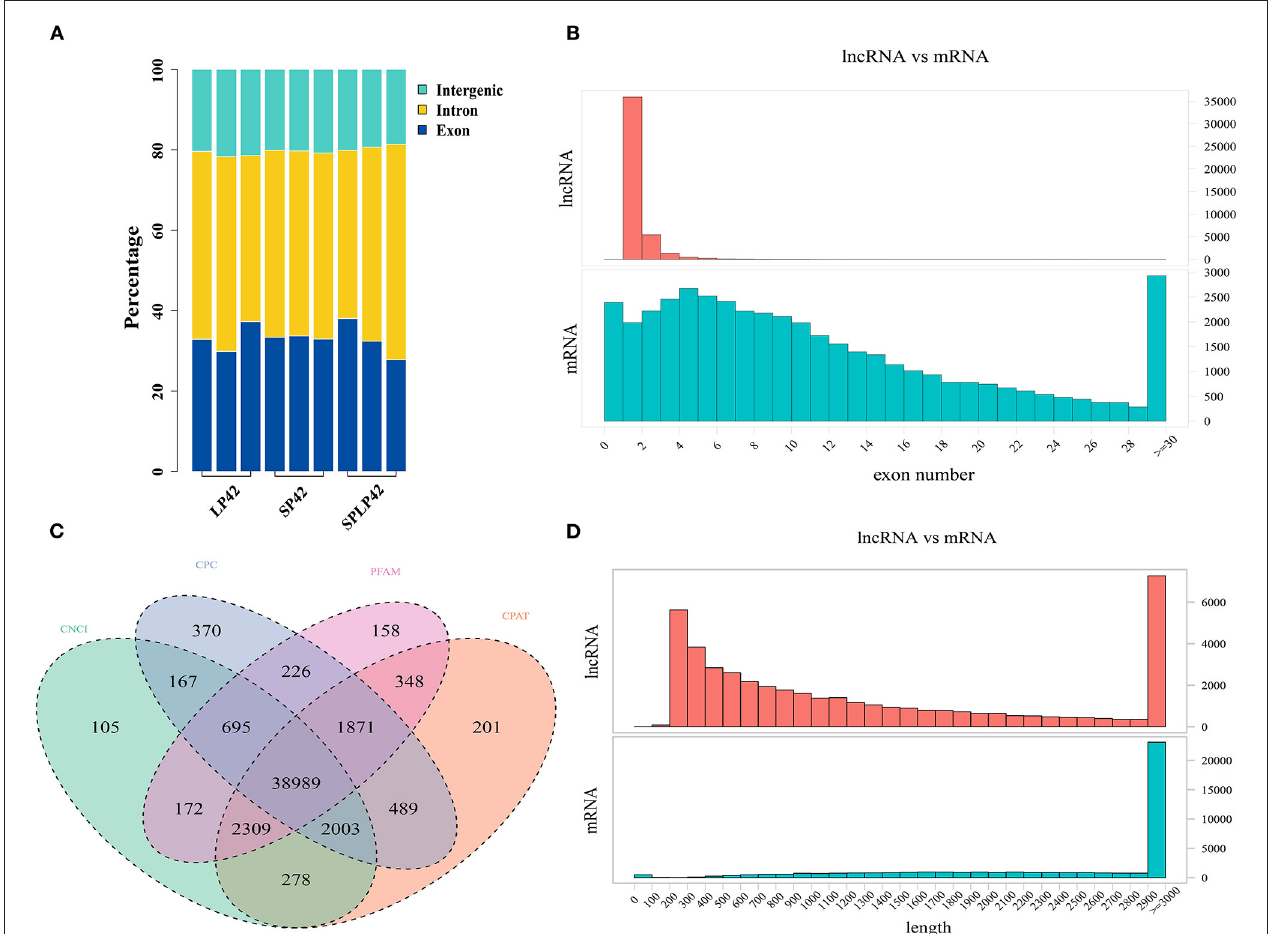
FIGURE 1 | Identification of lncRNAs and mRNA in sunite sheep adrenal gland. (A) The regions of identified long non-coding RNAs (lncRNAs) in short photoperiod for 42 days (SP42), long photoperiod for 42 days (LP42), and short photoperiod for 42 days and turn to long photoperiod for 42 days (SP-LP42). (B) The exon number of lncRNA and mRNA. (C) The results of novel lncRNA predictions by using CNCI, CPC, PFAM, and CPAT software tools. (D) The length of lncRNA and mRNA.